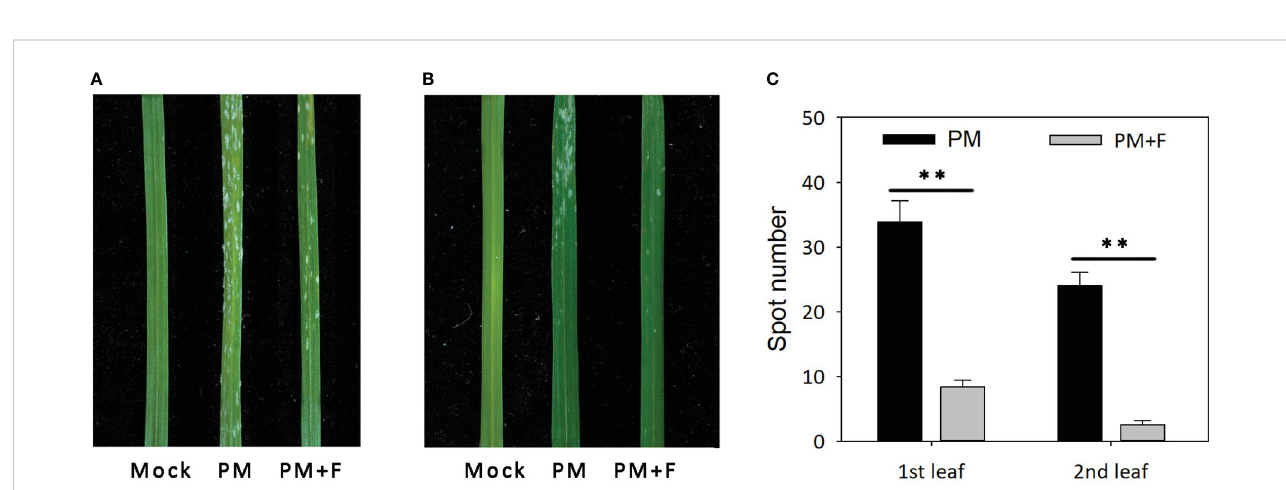
FIGURE 6 Effects of powdery mildew and fl avonoids treatment on leaf morphology in cv. Jimai229. Images of the representative phenotypes of the (A) fi rst leaves and (B) second leaves from the mock, PM, and PM+F groups. (C) Plot of the number of white spots observed on the leaves under the different conditions. Error bars represent mean standard deviation of triplicate experiments, with 10 leaves included per replicate. **, mean values differ signi fi cantly at the 1% probability level. PM, inoculated with powdery mildew; PM+F, inoculated with powdery mildew and treated with 100 m M fl avonoids solution.